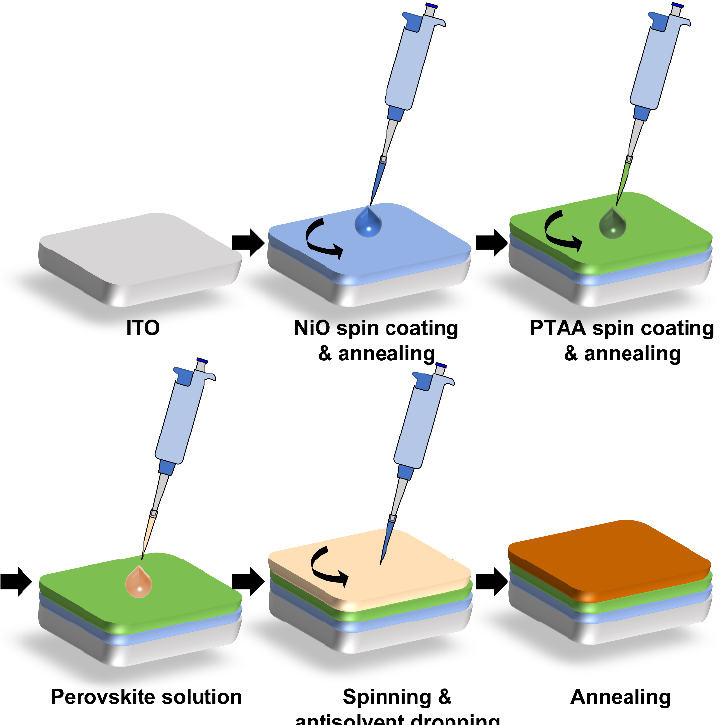
Figure 1. Fabrication of perovskite/PTAA/NiO films.